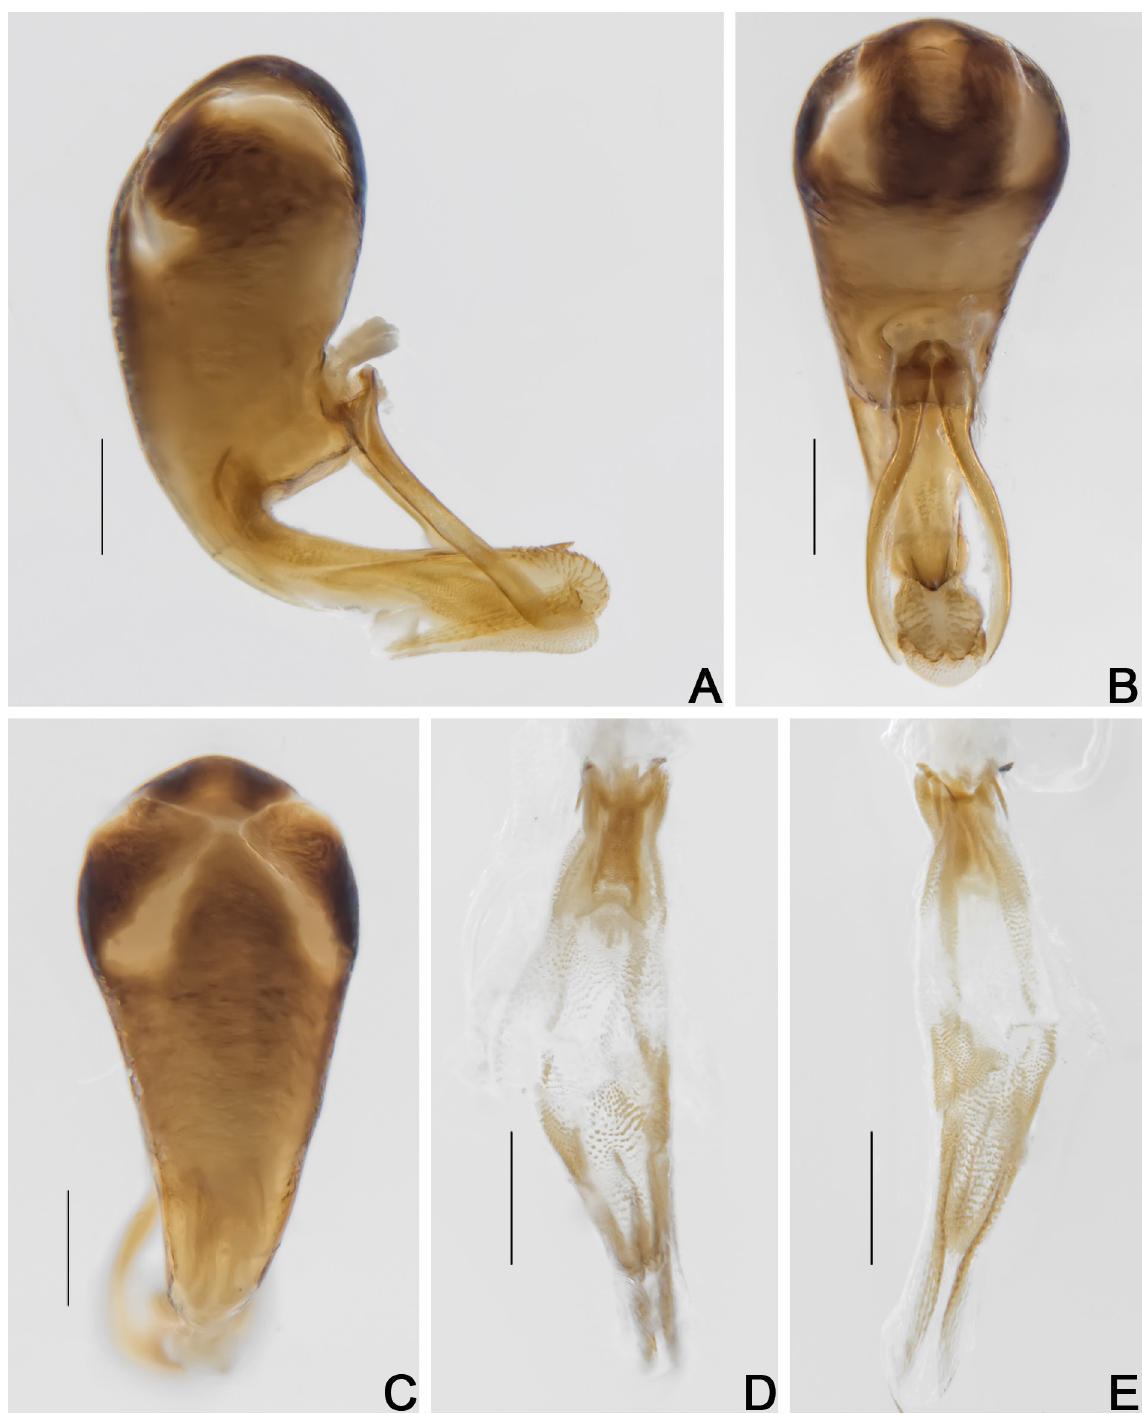
Fig. 28. Cyparium loebli sp. nov., paratype, ♂ (CELC). A–C . Aedeagus. A . Lateral view. B . Frontal view. C . Dorsal view. D–E . Internal sac. D . Frontal view. E . Dorsal view. Specimen collected at Mata do Paraíso, Viçosa (MG, Brazil). Scale bars = 0.2